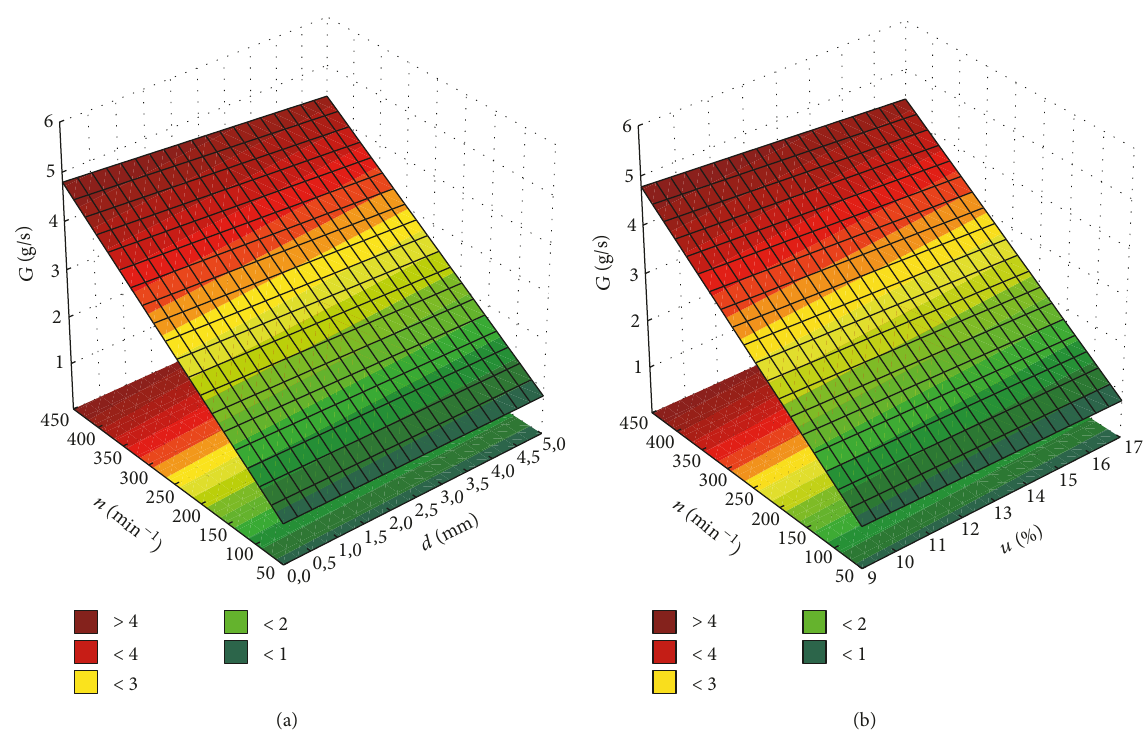
Figure 9: Model of the polymer mass flow rate G, response surface plots for the polymer mass flow rate G versus the screw rotational speed n and (a) width of the gap between the kneading elements d, (b) mass fraction of talc u.